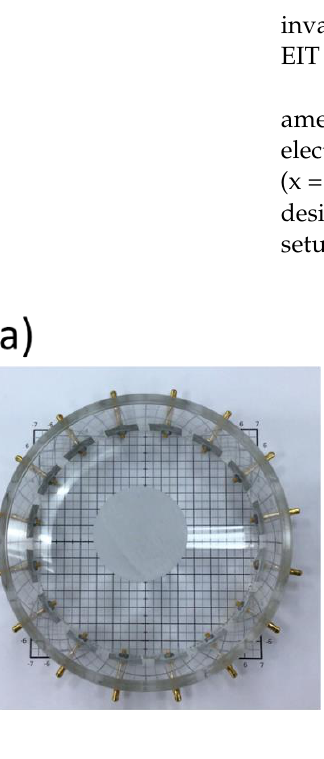
Figure 8. A cylinder acrylic tank and a wearable textile electrode belt. ( a ) An acrylic rod was placed in the acrylic tank. ( b ) Both sides of the wearable textile electrode belt.